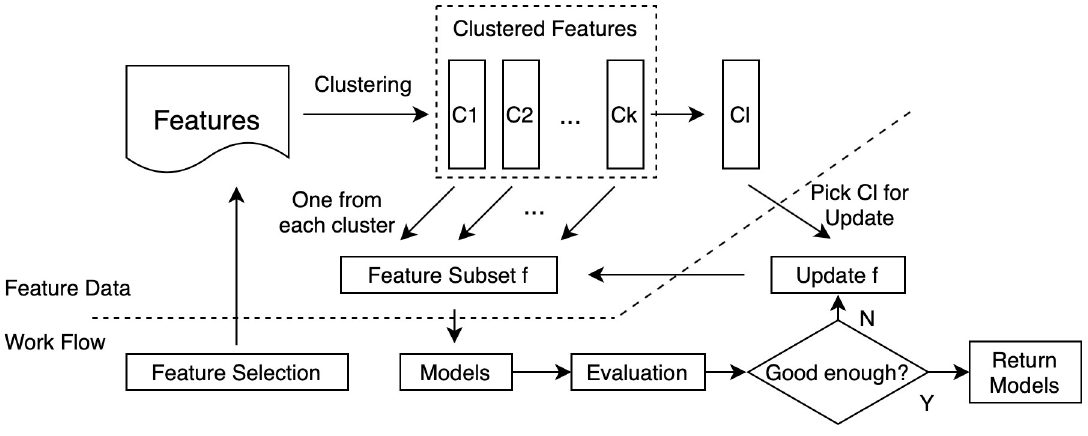
Fig 7. Clustering-based search.